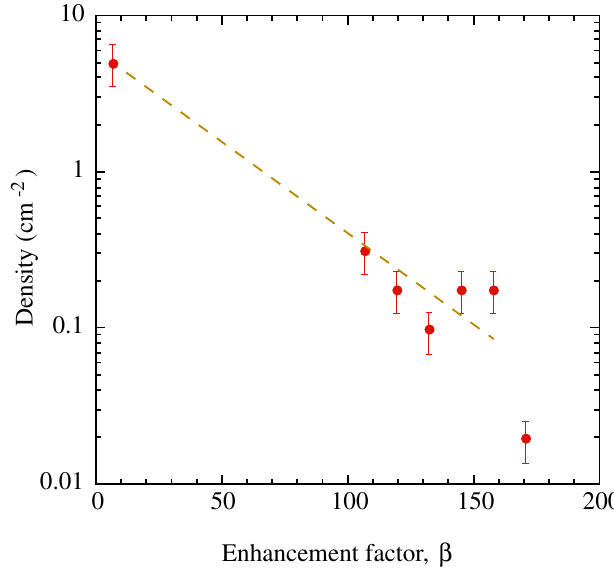
FIG. 3. (Color) The measured spectrum of secondary emitters, (cid:4) (cid:1) (cid:7) , evaluated from dark current beam measurements during s 2 cavity operation, from Ref.